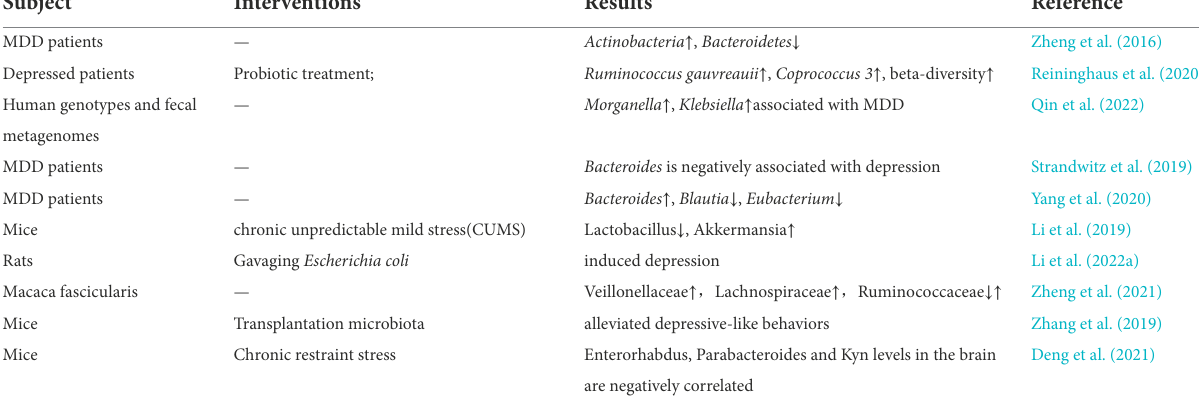
TABLE 1 Summary of the relationship between depression and gut